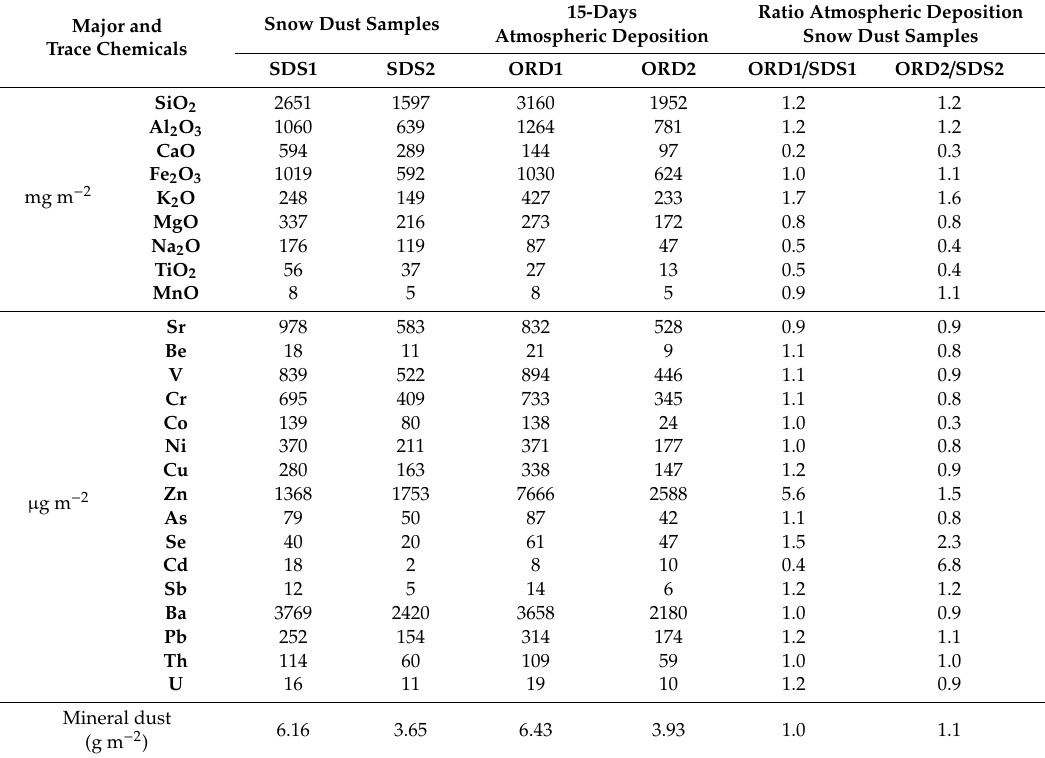
Table 1. Inorganic composition of two of the most intense Saharan dust events recorded. Snow samples (only dust layer) and atmospheric deposition samples (15-days of accumulation) are shown. Snow samples: SDS1 collected on 24 November 2016; SDS2 collected on 20 February 2017. Sampling at Ordesa: ORD1, from 22 November to 5 December 2016; ORD2, from 31 January to 14 February